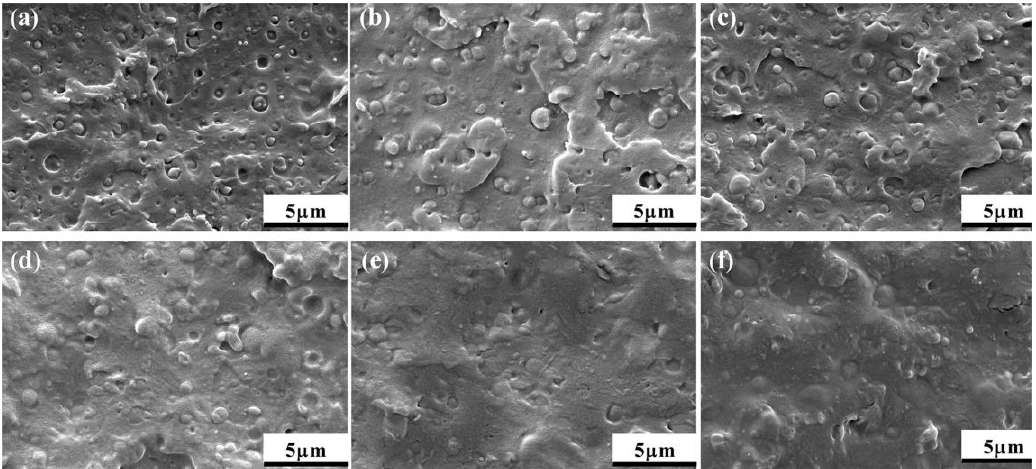
Figure 11. SEM micrographs of the cryofracture surfaces: ( a ) PLA / PCL; ( b ) PLA / PCL / 2; ( c ) PLA / PCL / 4; ( d ) PLA / PCL / 6; ( e ) PLA / PCL / 8; and ( f ) PLA / PCL / 10.